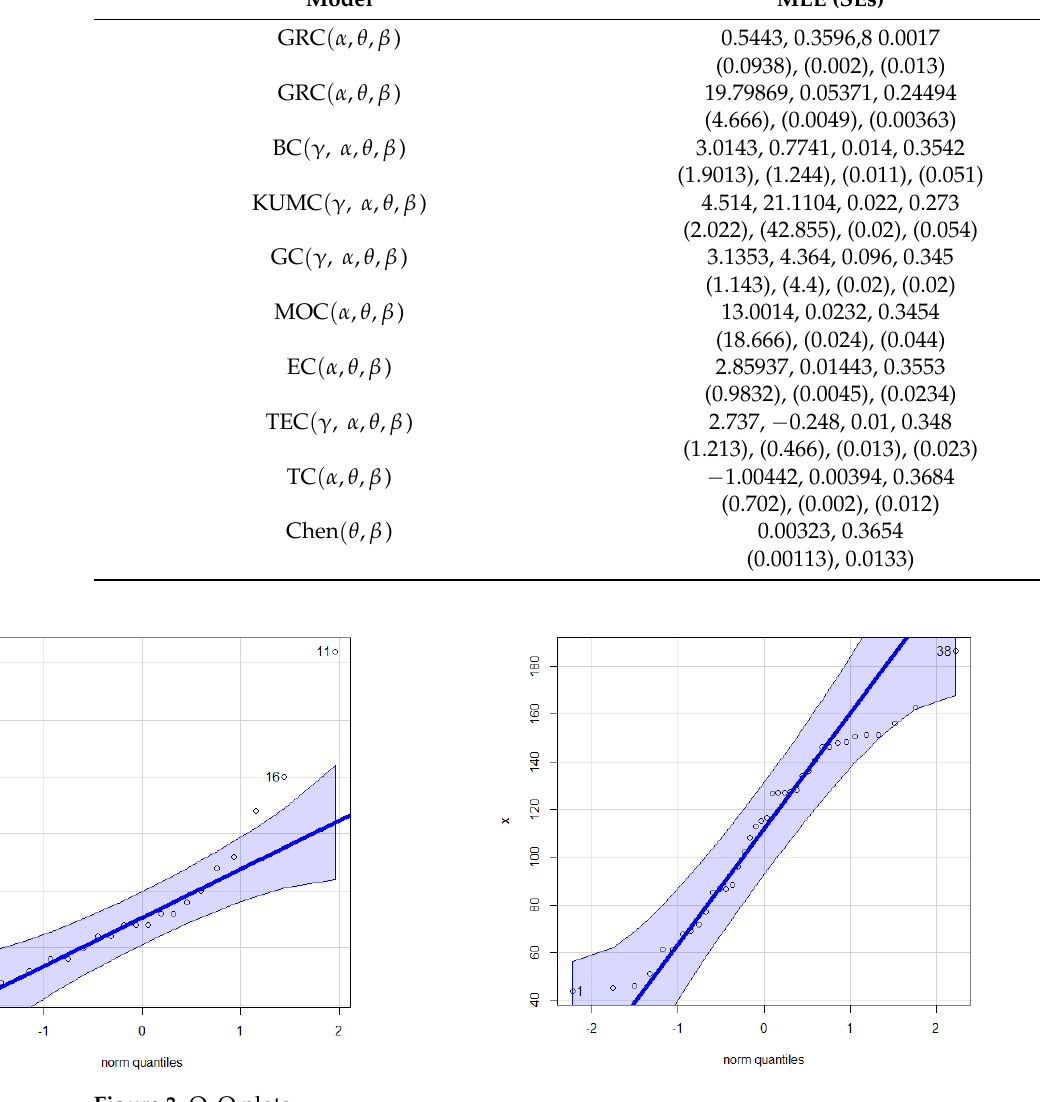
Figure 3. Q–Q plots. Figure 3. Q – Q plots.